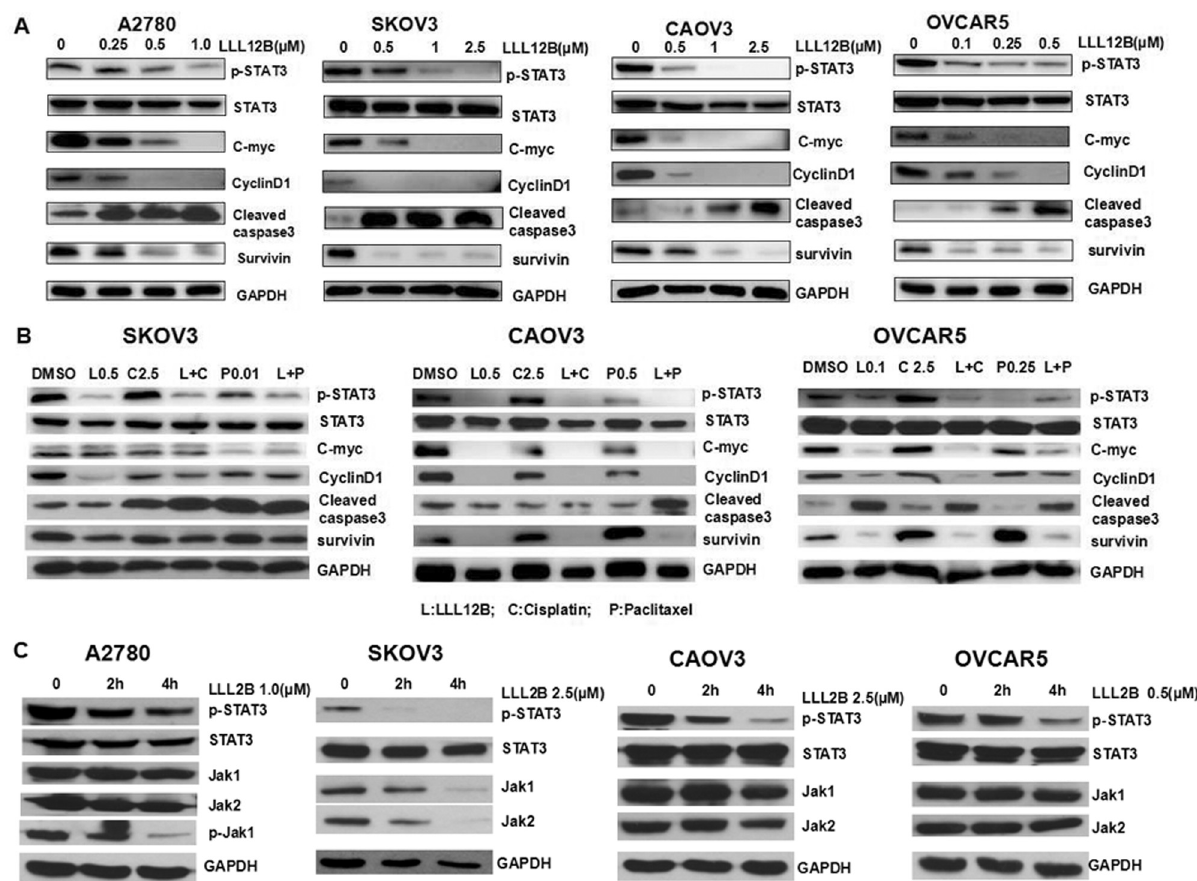
Fig 2. LLL12B inhibits p-STAT3 and its downstream targets in human ovarian cancer cells. A. The effects of LLL12B on STAT3 phosphorylation (Tyr705) and its downstream targets in ovarian cancer cell lines. A2780, CAOV3, SKOV3, OVCAR5 cells were treated with DMSO or different concentrations of LLL12B. The levels of p-STAT3 and the downstream target gene proteins were determined by Western blots. B. Compared with cisplatin or paclitaxel alone, the combination of LLL12 with cisplatin or/and paclitaxel appeared to have a greater inhibitory effect on p-STAT3 and some downstream target gene proteins in CAOV3, SKOV3 and OVCAR5 cells. C. Treated with LLL12B by 0h,2h and 4h, p-STAT3 was inhibited in four cell lines, p-Jak1 was only inhibited in A2780; p-Jak2 was not detected. Total Jak1, Jak2 in SKOV3 was reduced. The total STAT3 and total Jak1, Jak2 in other three cell lines were not